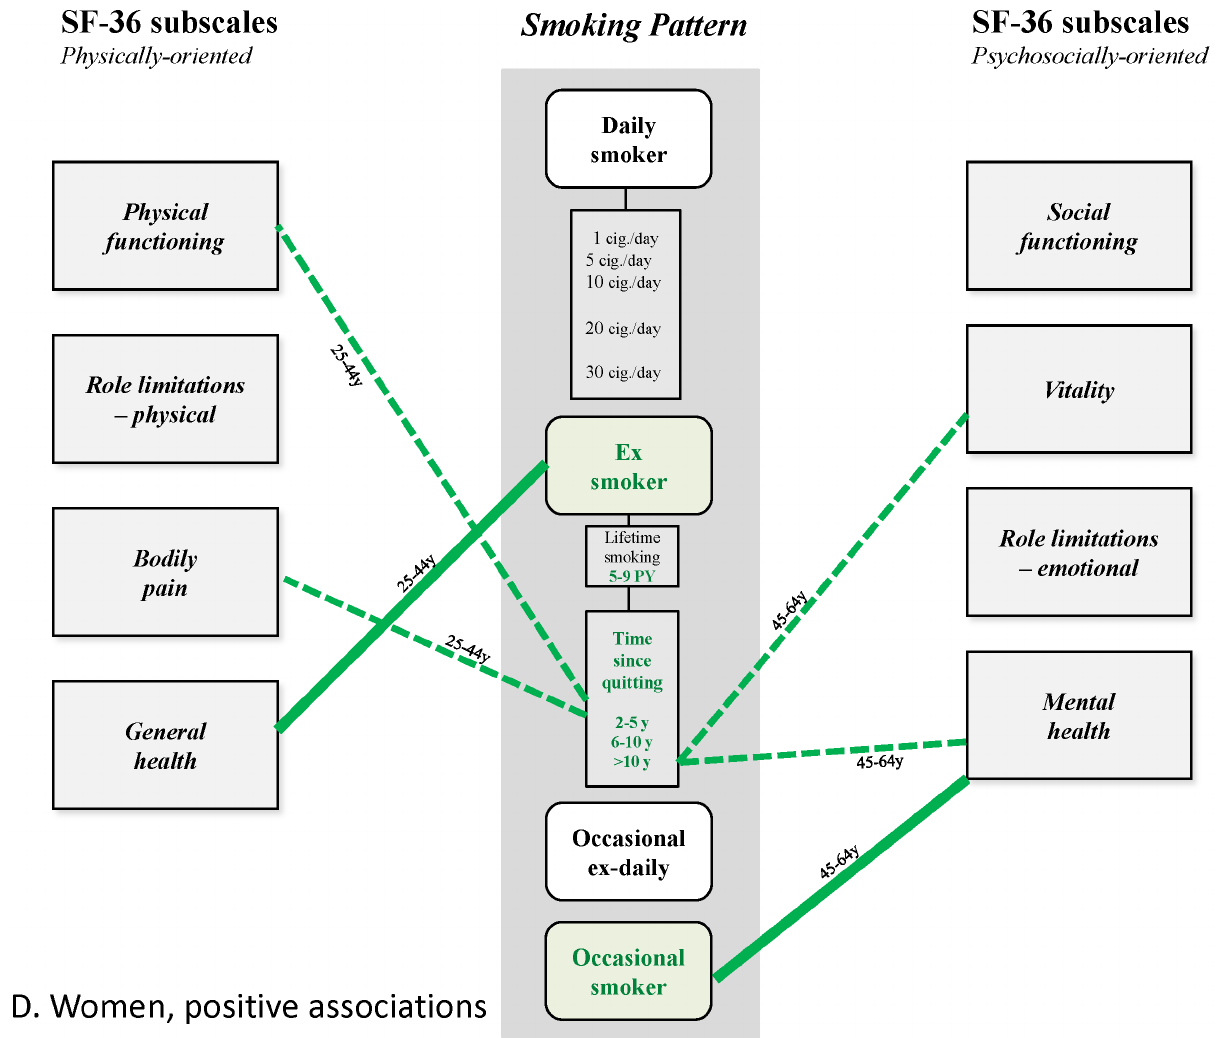
Figure 7. Patterns of relationships found in this study. Women, negative associations.